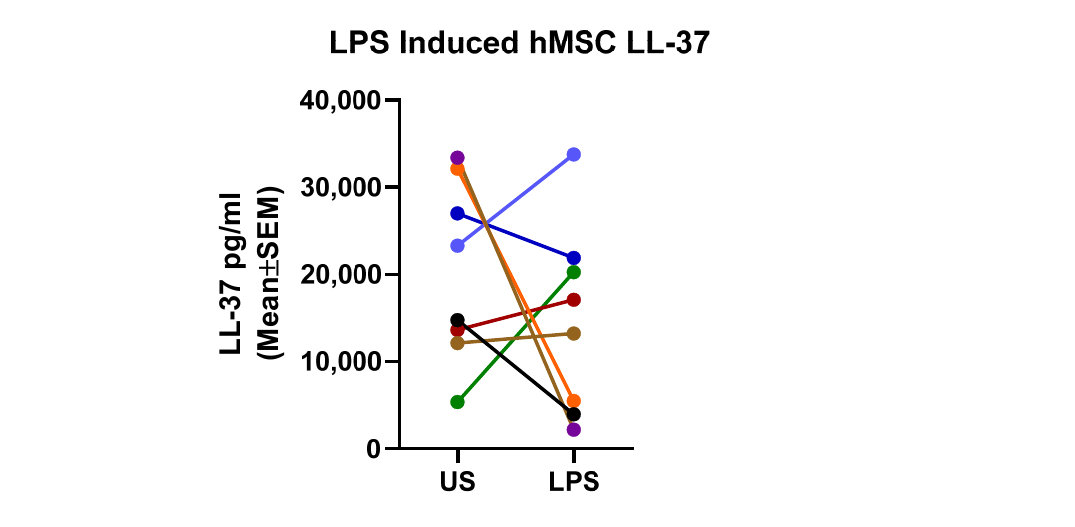
Figure 4. hMSC LL-37 Production. Each of the hMSCs were screened for the ability to secrete the anti-microbial peptide LL-37 in the presence and absence of a direct stimulation with LPS (10 µ g/mL, n = 8). All eight pre-GMP hMSC donors secreted LL-37 (20,225 ± 9499 pg/mL, mean ± SD).